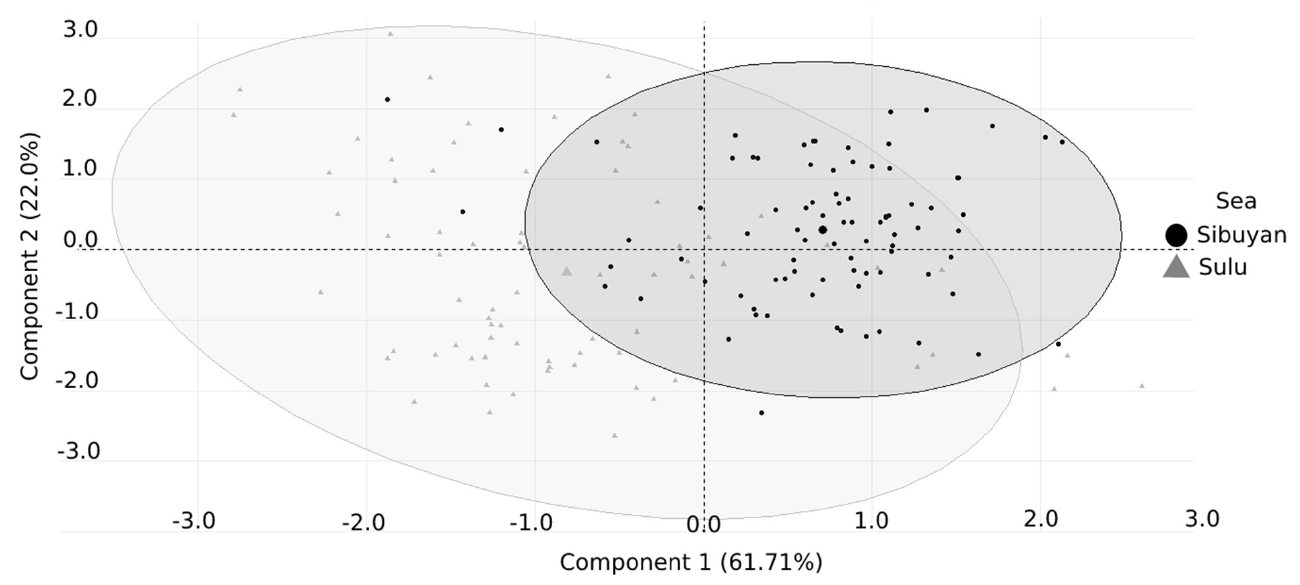
Figure 5. Principal Component Analysis (PCA) plot of descriptor measurements of the two stocks of D. kurroides collected from Sulu and Sibuyan seas.